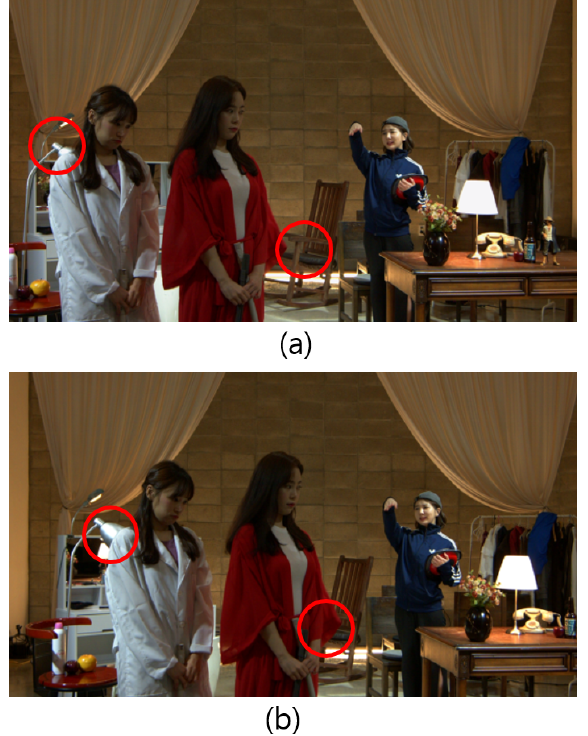
Figure 4. Disparity estimation is performed by calculating the difference of the horizontal coordinates of two adjacent images ( a , b ). Disparity estimation is inaccurate or impossible to estimate due to the existence of occlusion (e.g., occlusion is observed in the areas of the red circles in ( a , b ). Contrary to the usual stereo vision method, the present work uses 25 cameras, each of which is located at different positions, and accounts for the occlusion problem, which can be resolved because multiple (more than two) viewpoints are available. The number of viewpoints enables us to generate a depth map of reliable quality with 25